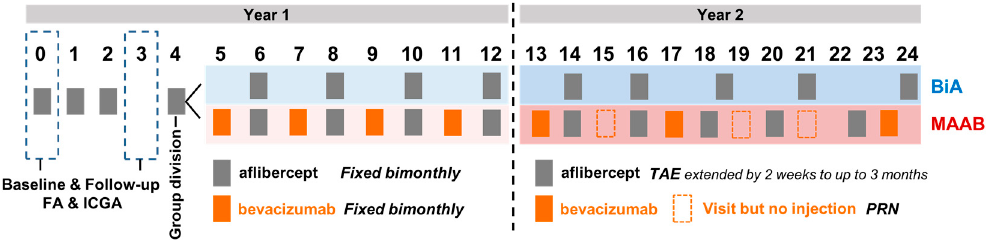
Figure 1. Treatment protocols. BiA = bimonthly aflibercept, MAAB = monthly alternating injections of aflibercept and bevacizumab, TAE = treat-and-extend, PRN = pro re nata.